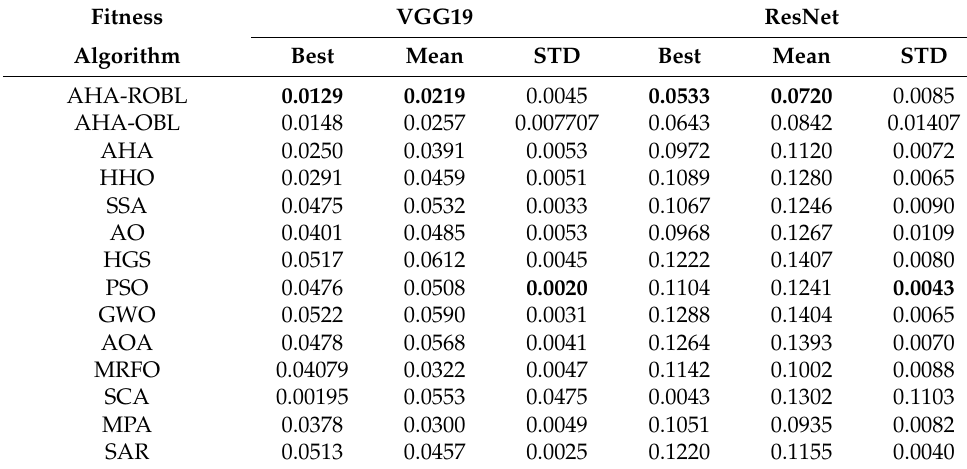
Table 2. Comparison of the performance of deep features models of the AHA-ROBL with other recent optimizers versus avg. fitness.